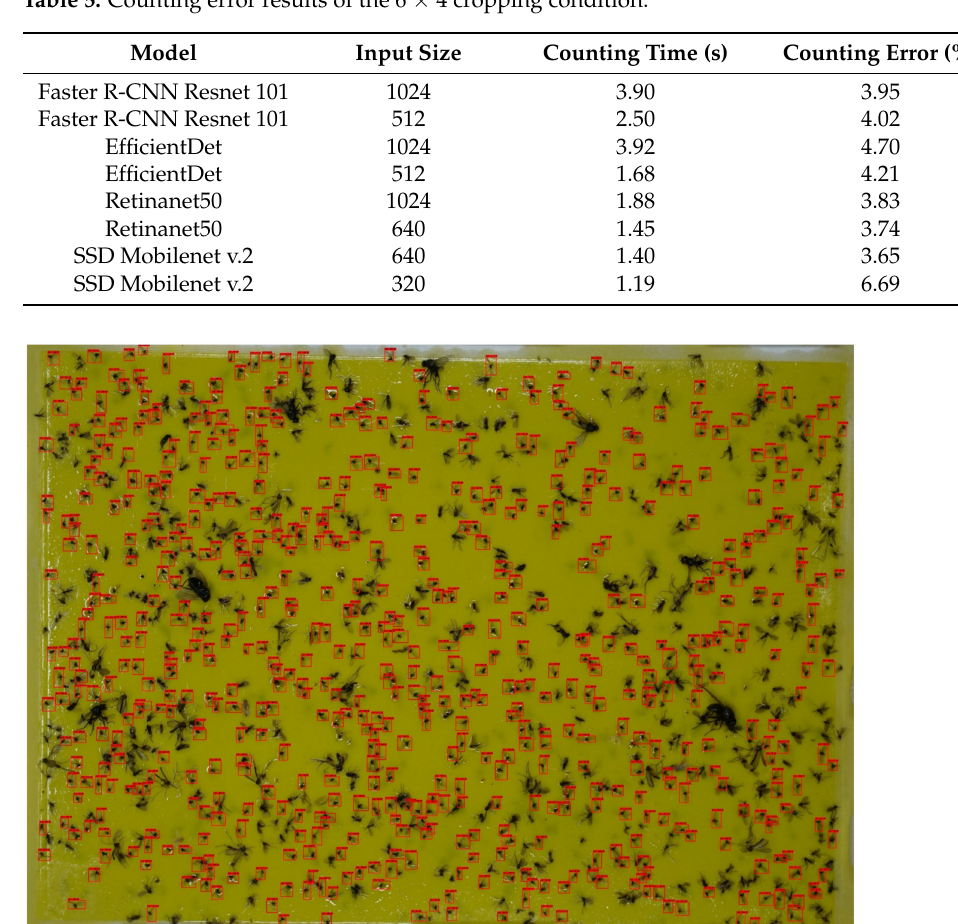
Table 5. Counting error results of the 6 × 4 cropping condition.